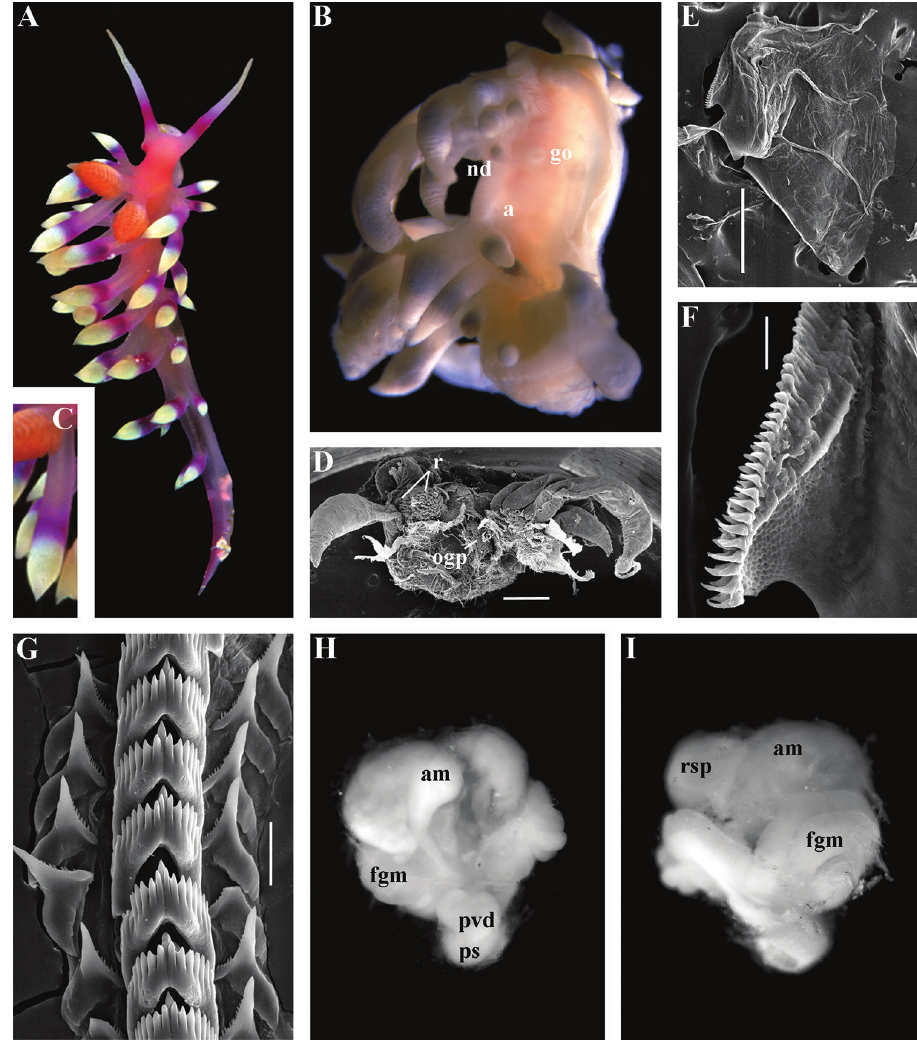
Figure 37. Coryphellina exoptata (Gosliner & Willan, 1991), comb. n. Vietnam, Nhatrang Bay. ZMMU Op-116, living specimen 9 mm in length: A dorsal view B ventral view (fixed) C details of cerata D dis- sected anterior part (pharynx removed) and rhinophores, SEM E jaw, SEM F details of masticatory process of jaw, SEM, scale bar = 30 μm G radular teeth, posterior part, SEM H, I reproductive system, light mi- croscopy. Abbreviations: a anus am ampulla fgm female gland mass go genital opening nd discontinuous notal edge ogp oral gland penetrating into basis of cerata ps penial sheath r rhinophores rsp proximal receptaculum seminis pvd prostatic vas deferens. Scale bars: D = 1 mm; E = 300 μm; F = 30 μm. Photos of living specimens by O.V. Savinkin, other photos and SEM images by A.V.